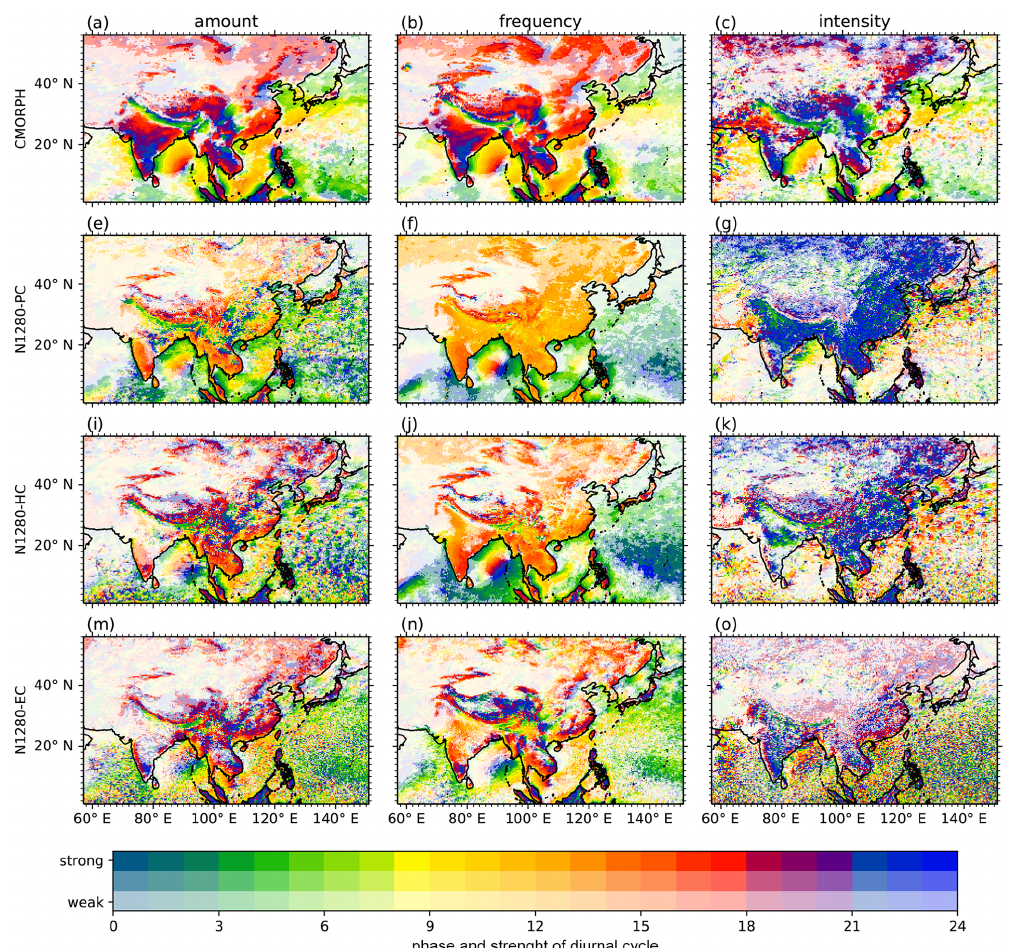
Figure 6. The diurnal cycle of the amount, frequency and intensity of precipitation over Asia for CMORPH and the three high-resolution simulations, showing the phase in LST in colour and the amplitude by the opacity of the colour. The diurnal cycle is considered strong if its amplitude is in the top third of the Asia-wide amplitudes over the whole domain (including oceans), weak if it is in the bottom third and medium otherwise (Sect. 2.3). Note that the strength of the diurnal cycle is calculated separately for each dataset. Thus, it is possible to say that all datasets have a weak diurnal cycle for the amount of precipitation over the north-western region of the domain but not that the magnitude of the amount is similar where the diurnal cycle is considered strong. An absolute comparison is done in Fig.